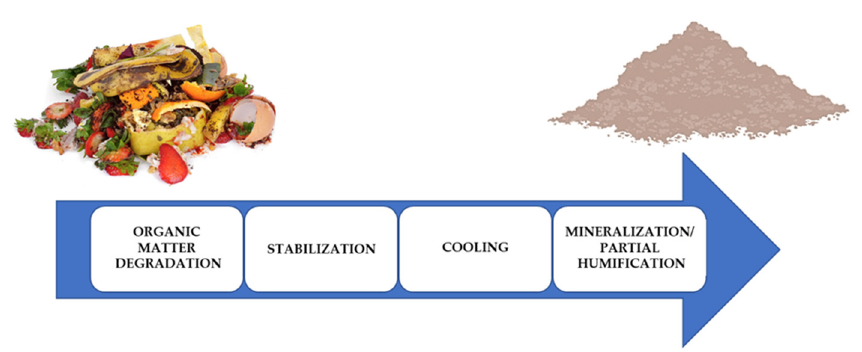
Figure 2. Composting phases.